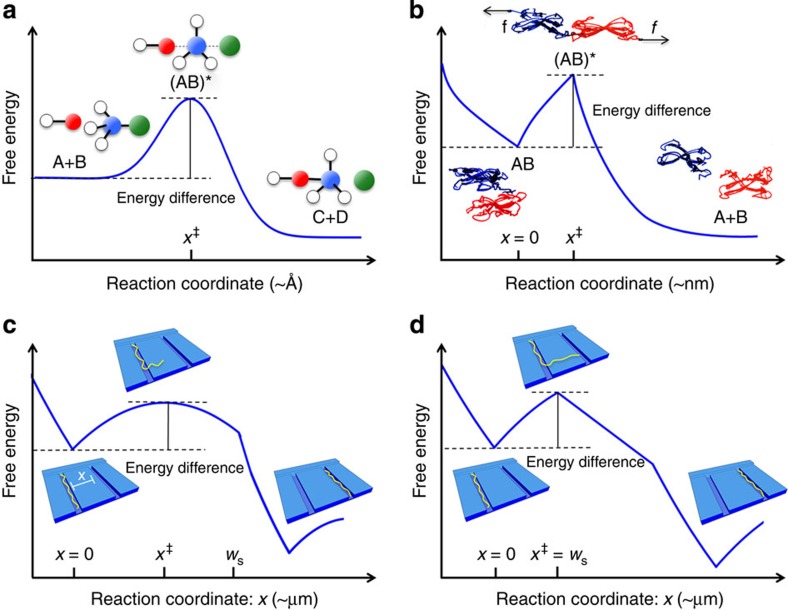
The scenario of TST.A free-energy landscape is traversed by a reaction pathway that is
parameterized by a reaction coordinate;12 typical length
scales of reaction pathways are given in parentheses. Insets portray
physical situations corresponding to (quasi) equilibrium and transition
states (at x†). (a,c) Transition
states that will change location on the reaction pathway with the strength
of an applied force, exemplified by (a) a chemical reaction (with
transition state (AB)*), and in the present study (c) a polymer
crossing an entropic barrier in the form of nanoslit separating two
nanogrooves, where the transition state lies inside the nanoslit.
(b,d) Sharp transition states that are independent of an
applied force, similar to the situation in chemical bond rupture; here
exemplified by (b) the separation of two binding proteins under an
external force (with transition state (AB)*), and in the present study
(d) a polymer crossing through a nanoslit where the transition
state is located at the end of the nanoslit. In c,d the
reaction coordinate x parameterizes the continuous shifting of DNA in
a transition from the upstream to the downstream nanogroove. Specifically,
it measures the extension of the leading end of the DNA into the nanoslit,
until this end of the DNA enters the next nanogroove, which happens at
x=ws. For
0<x<ws, x is approximately
proportional to the contour length ℓ of the DNA that has left the
upstream nanogroove. After the leading end of the DNA has entered the
downstream nanogroove, we let x denote a fixed fraction of the
contour length ℓ of the DNA that has left the upstream nanogroove, the
same fraction as x denoted for 0<x<ws.
Note that we need not know the value of this fraction, and its existence can
be an approximation. The qualitative picture described here still captures
the essence of Fig. 2's experimental
observations of transitions. The trailing end of the DNA leaves the upstream
nanogroove when ℓ equals the full contour length of the DNA molecule,
LDNA. We denote the value of x at that point by
x=xDNA. After this point, we let
x denote xDNA plus the distance that the DNA
molecule's trailing end has moved into the nanoslit. After the DNA has
completely entered the next nanogroove, the landscape repeats itself as from
x=0 (see also Fig. 3).